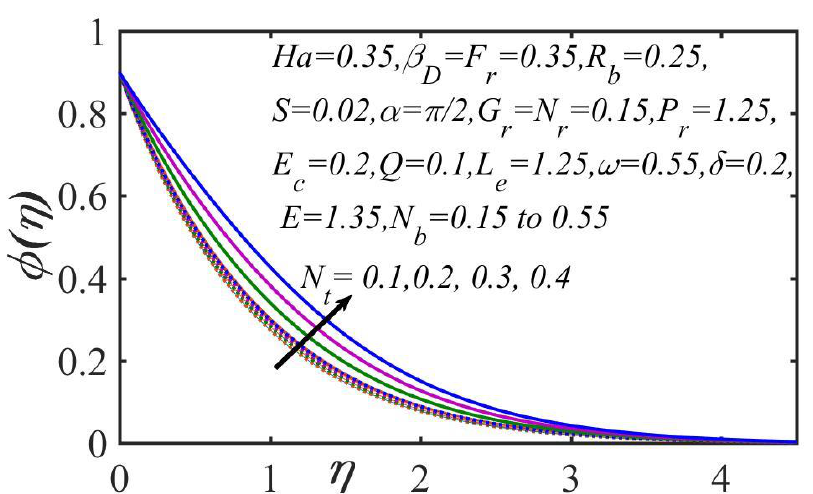
Figure 10. Impact of 𝑁 𝑡 and 𝑁 𝑏 on the concentration magnitudes. Solid curve: 𝑁 𝑏 = 0.15 ; dotted curve: 𝑁 𝑏 = 0.55 .